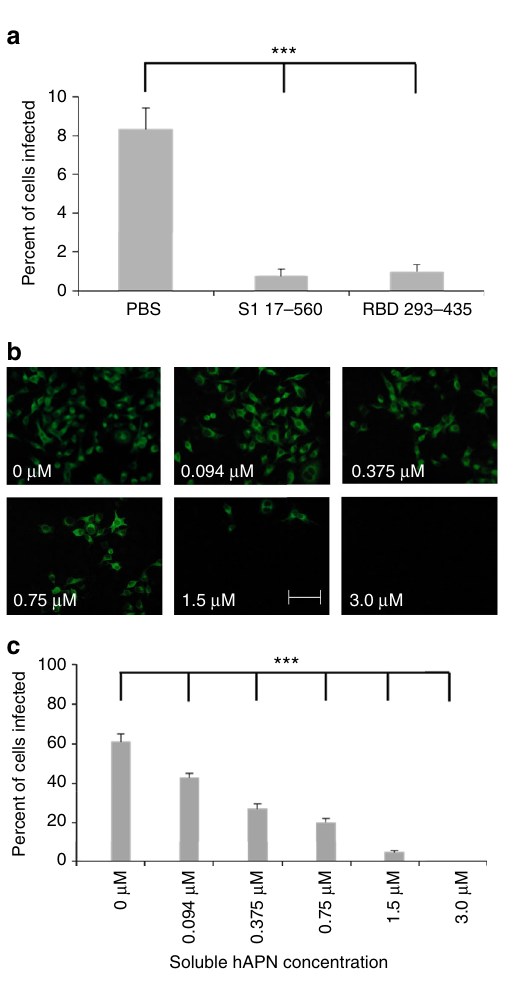
Fig. 1 Characterization of soluble fragments of the HCoV-229E S-protein and hAPN. a HCoV-229E infection of L-132 cells in the presence of: PBS, the HCoV-229E S1 domain (residues 17 – 560 at 10 µ M), and the HCoV-229E RBD (residues 293 – 435 at 30 µ M). Statistics were obtained from three independent experiments. Statistical signi fi cance (ANOVA): *** p < 0.001; error bars correspond to the standard deviation. b Representative images of HCoV-229E infection of L-132 cells in the presence of the hAPN ectodomain at various concentrations. Green fl uorescence measures the expression of the viral S-protein. Magni fi cation (100×) and scale bar = 20 µ m. c Quantitation of the hAPN inhibition experiment. Statistics were obtained from three independent experiments.